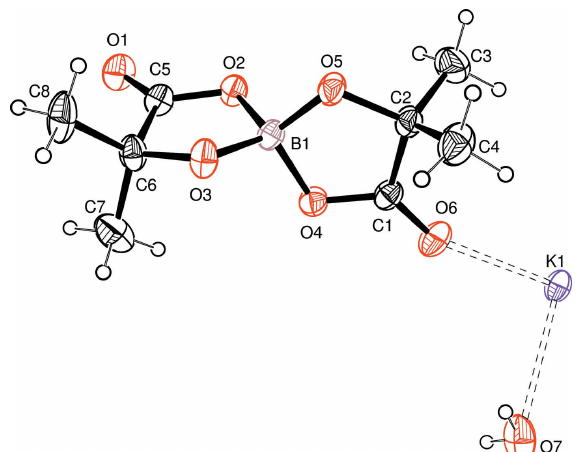
Figure 1 A view of the asymmetric unit of the title compound showing the atom numbering with displacement ellipsoids drawn at the 25% probability